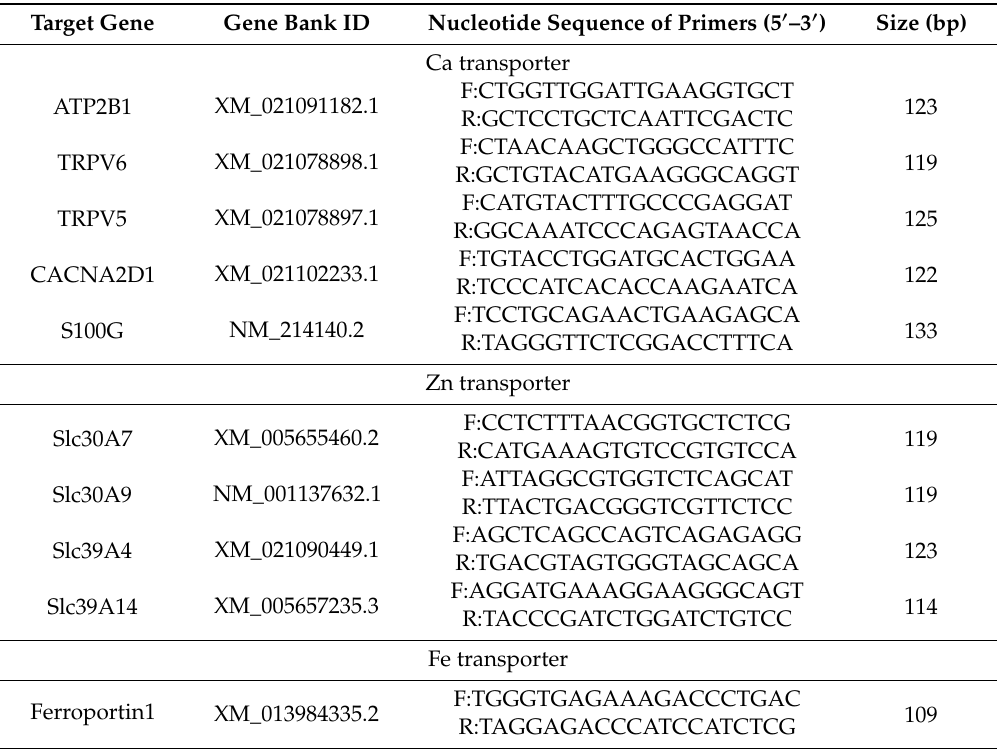
Table 2. Sequence of primers for real time-polymerase chain reaction. Target